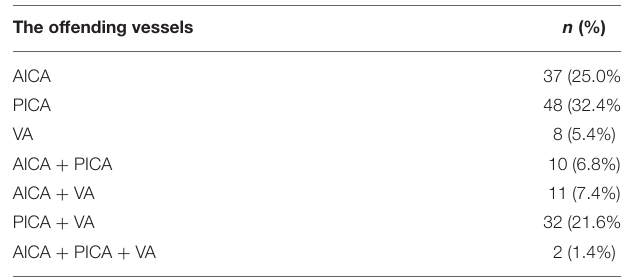
TABLE 2 | Statistical results of the offending vessels.